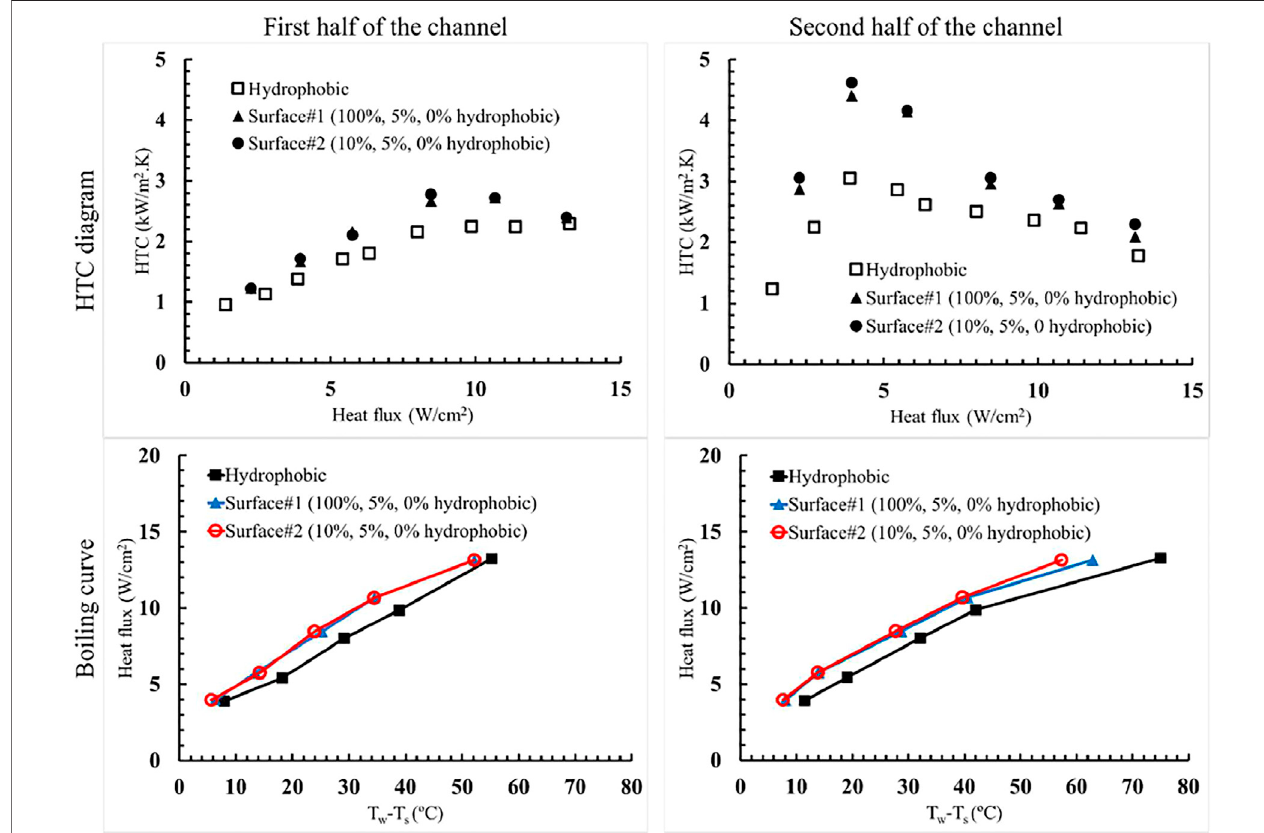
FIGURE 5 | Heat transfer coef fi cients (HTCs) and boiling curves corresponding to the mass fl ux of 90 kg/ m 2 s.